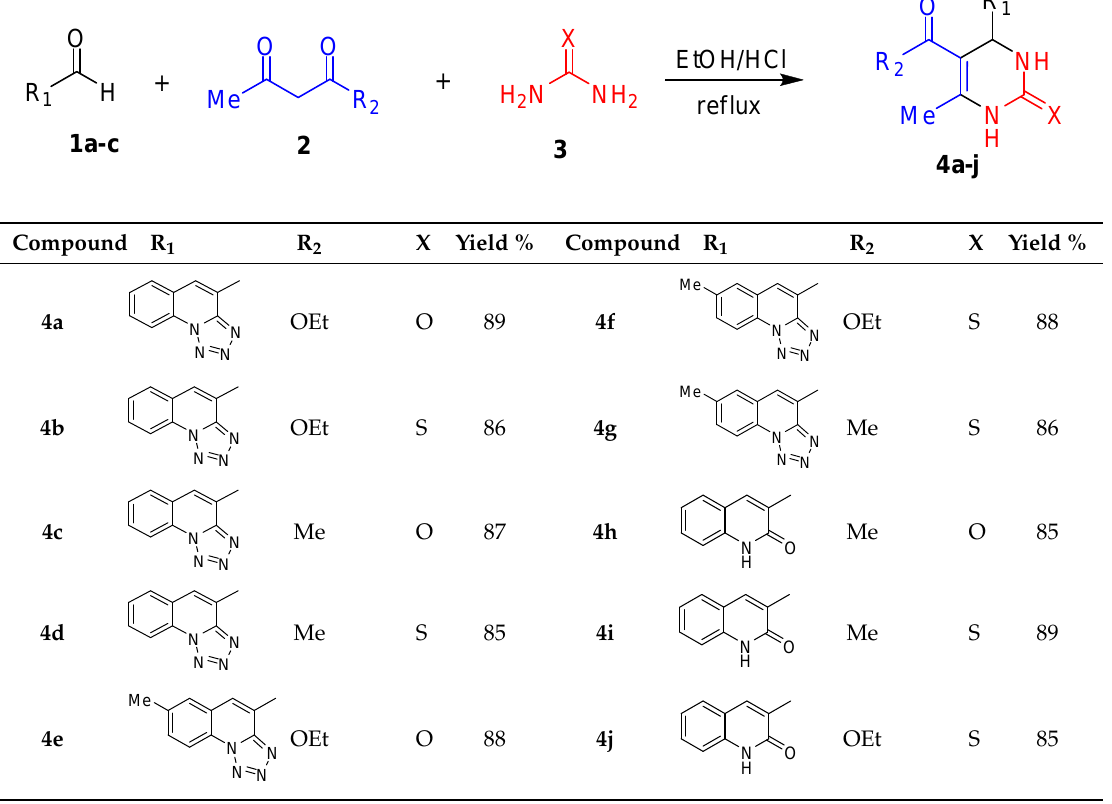
Scheme 1. Synthesis of dihydropyridine (DHPMs) 4a – j . OHO N 1d